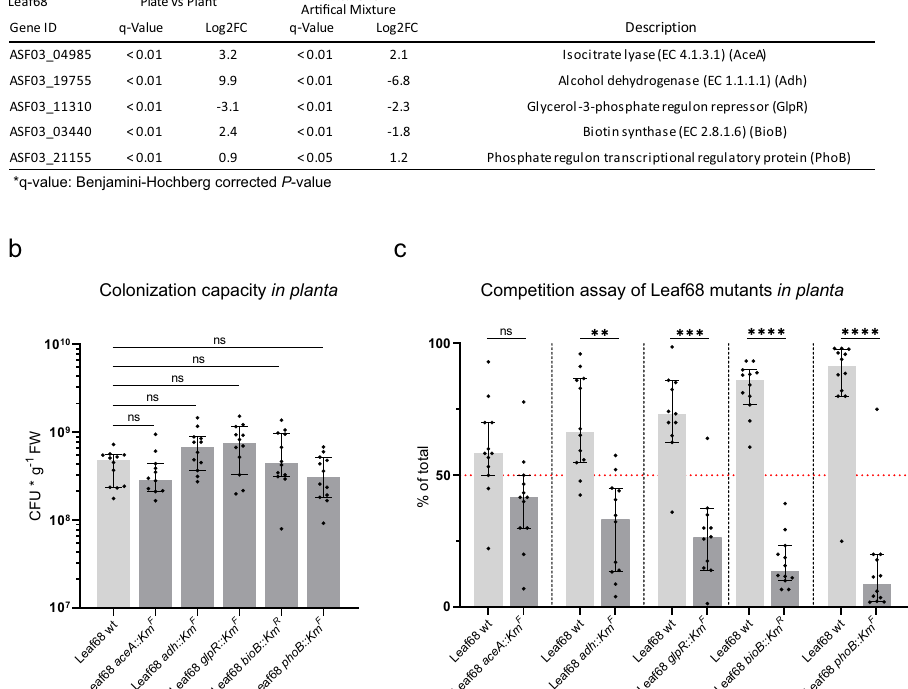
Fig. 4 Characterization of Rhizobium Leaf68 mutants in planta . a Overview table of the fi ve genes of Rhizobium Leaf68 selected for mutagenesis and fold- changes of the encoded proteins over the different proteomics conditions (Supplementary Data 2 and 5). P- values were calculated using a one-way ANOVA and adjusted for multiple comparisons using Benjamini-Hochberg. b Colonization capacity of each (CFUs per gram fresh weight), Leaf68 wild type (light gray), mutants (dark gray) alone in planta . Statistical analysis was performed using Kruskal – Wallis test. c Competition assay depicting the percentage (%) of total population wild type versus each mutant respectively. A 1:1 mixture is indicated at 50% with a red dotted line. For statistical analysis a two- sided paired t-test was performed ( P -values: * p -value < 0.05, ** p -value < 0.01, *** p -value < 0.001, and **** p -value < 0.0001). In graphs b and c, the median and 95% con fi dence interval are shown. For both graphs each data point represents the values obtained from a single plant with a total of 12 plants for these experiments. Source data for ( b , c ) are provided as a Source Data fi